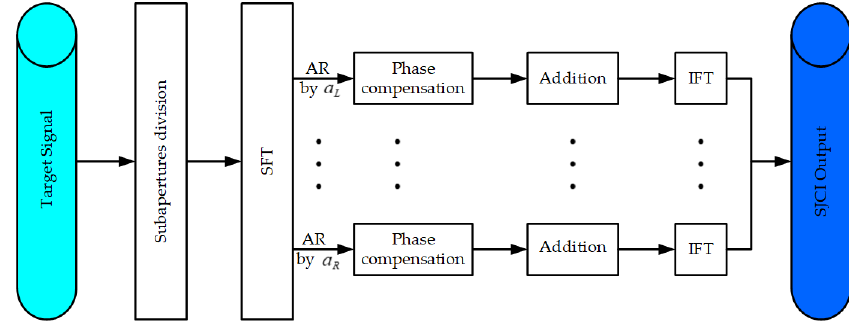
Figure 2. The flow chart of the SJCI